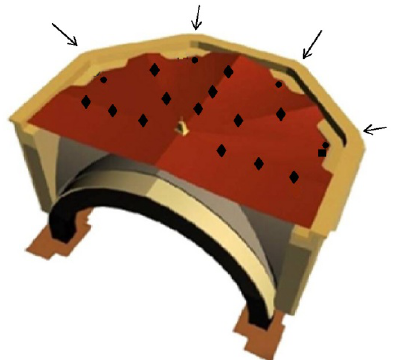
Figure 1. Perspective of the upper part of the apse and terrace above the frescoes. The four arrows indicate the position of storm drains. Six sensors are located at the terrace: four touch-switch sensors activated in case of flooding by obstruction of the drainage channel (circles) and one rain-activated touch-switch sensor (square). The position of ventilation tubes is also indicated